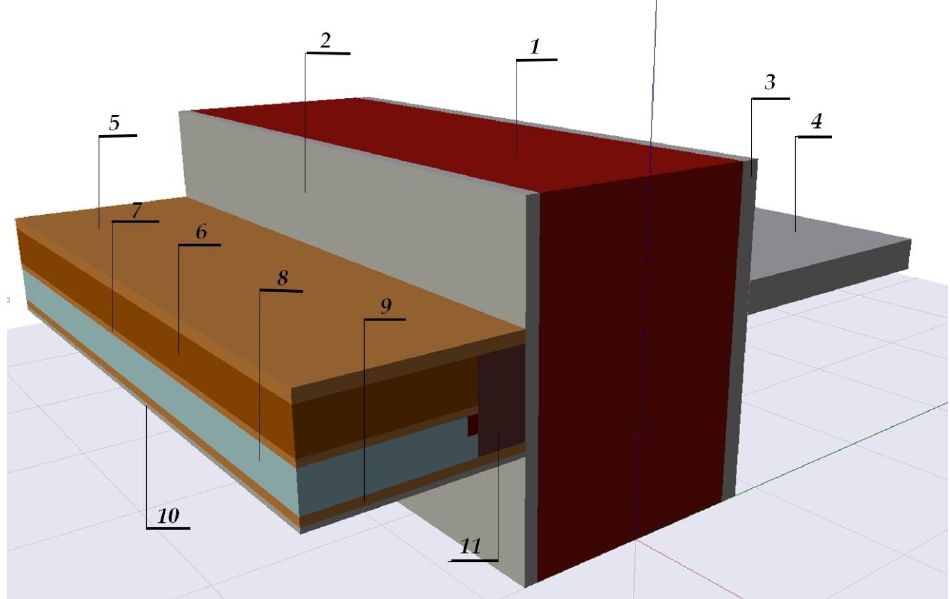
Figure 13. Geometric model—solid view from inside the room: (1) brick wall; (2) lime–cement plaster; (3) clay–lime plaster; (4) balcony (concrete slab on steel beams); (5) timber flooring; (6) slag; (7) wooden boards; (8) air void; (9) ceiling board; (10) lime–cement plaster; (11) wooden beam.